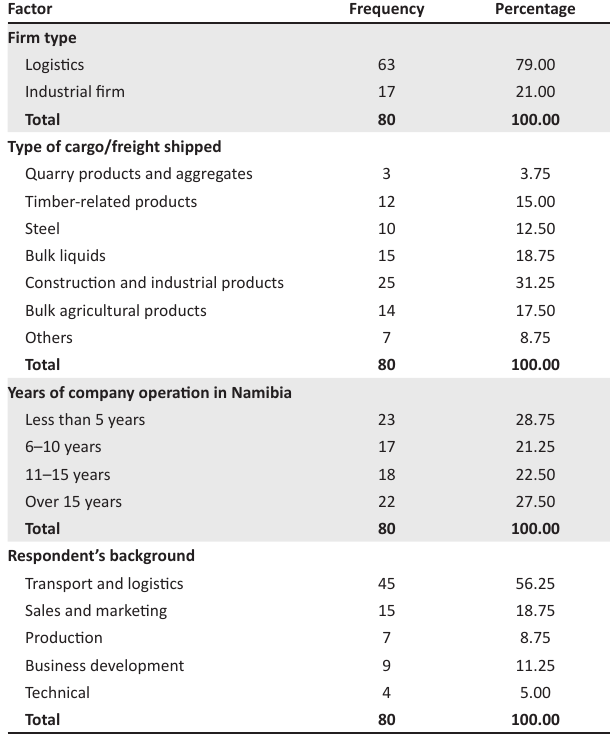
TABLE 1: Respondent company profile and